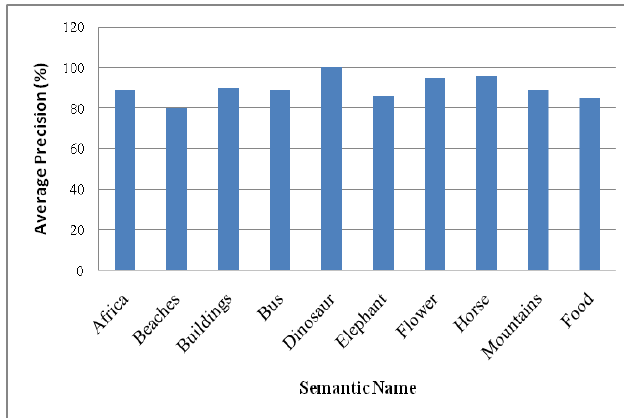
Figure 9. Average value of precision of 10 categories of Corel-1K database